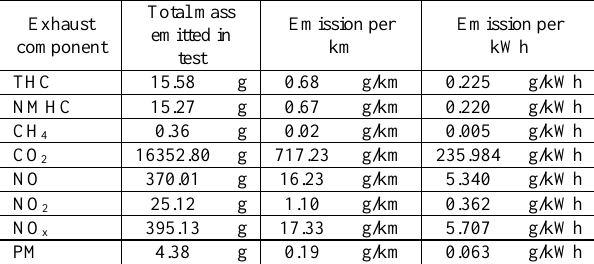
Table 4. Selected engine emission factors in